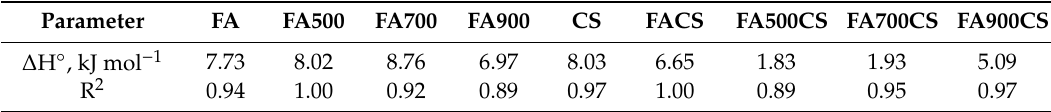
Table 6. Free enthalpies ∆ H ◦ and correlation coe ffi cients for the linear fit of experimental points to Equation (17). Parameter FA FA500